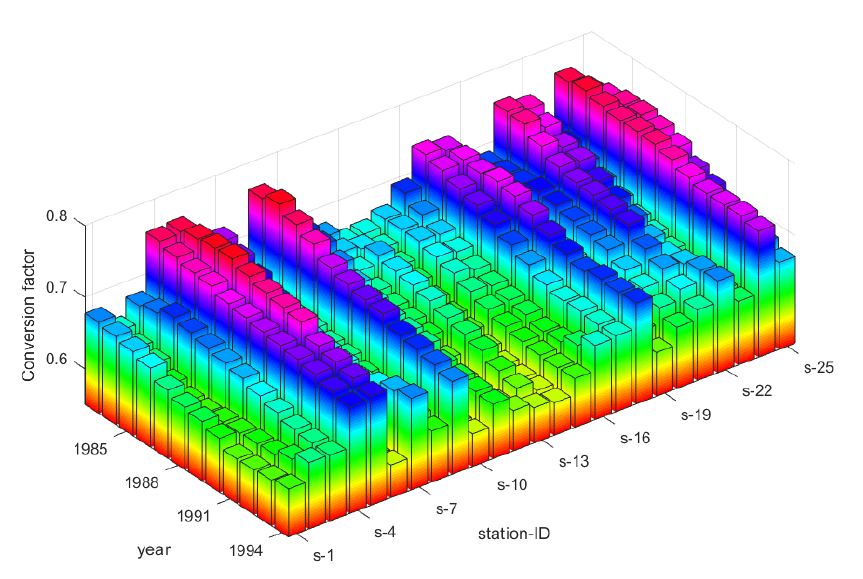
Figure 10. Matrix of conversion coefficients for two pans for the second cycle (series length of 12 years.